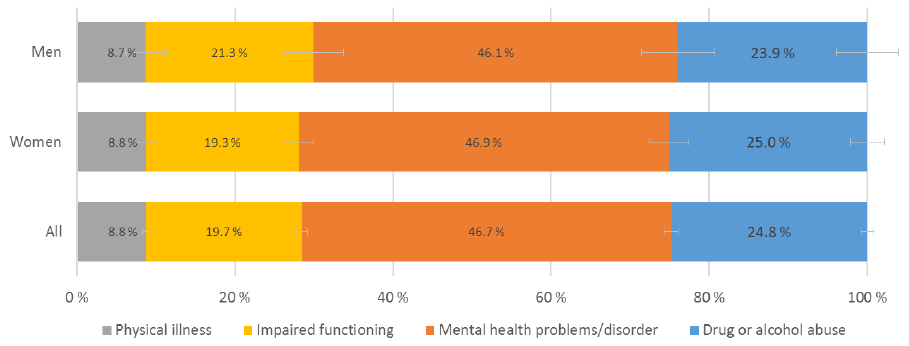
Figure 1. Distribution of type of illness in care-receiver.